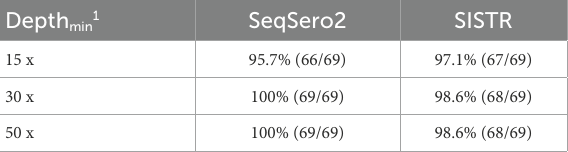
TABLE 3 Accuracy of Salmonella serotype prediction using assembled genomes from ONT multiplex sequencing data. Depth min1